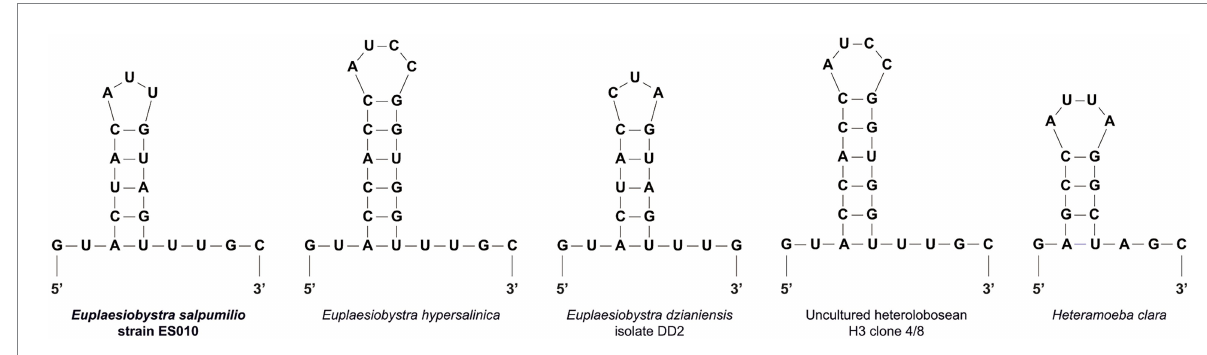
FIGURE 3 Putative secondary structures of the helix 17_1 in the 18S rRNA molecules of the Euplaesiobystra group and Heteramoeba clara . Note that all heterolobosean species except Pharyngomonas strains has the helix 17_1